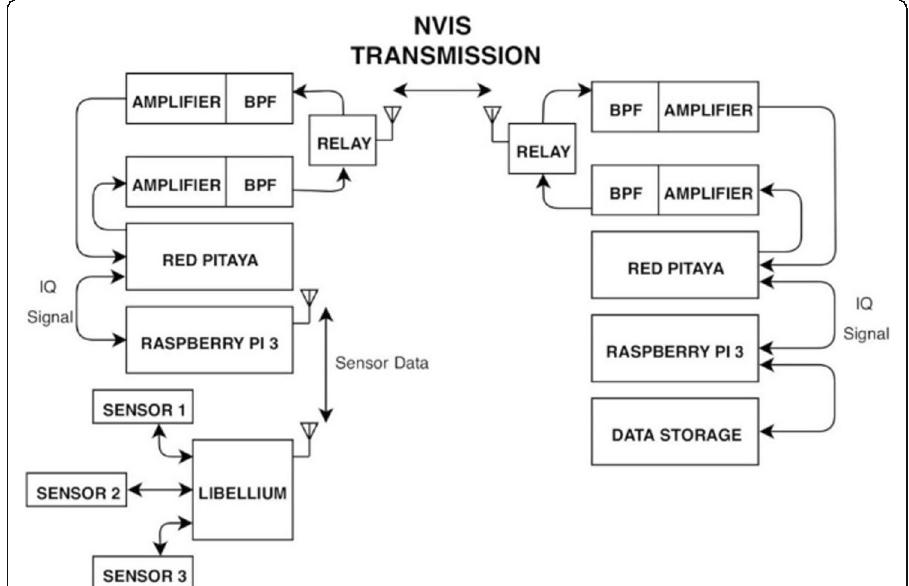
Fig. 19 Block diagram of the NVIS node. Block diagram of the NVIS node hardware and software. This figure shows how data is modulated and transmitted from the data acquisition, to the reception and data